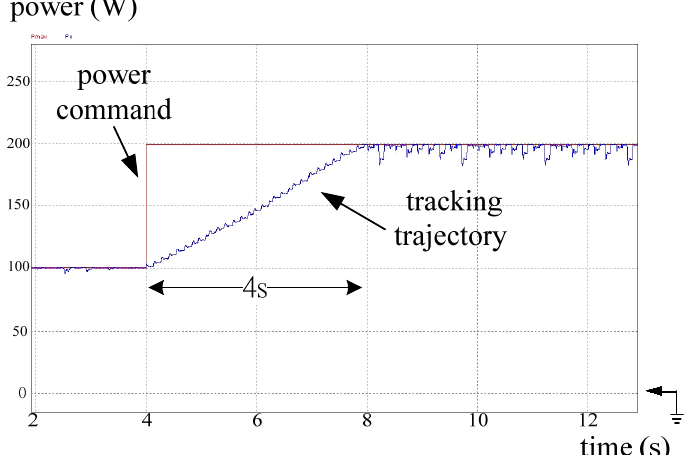
Figure 18. Simulated result: tracking trajectory of the converter with the POM while PV power steps up from 100 to 200 W. Note: power: 50 W/div; time: 2 s/div.